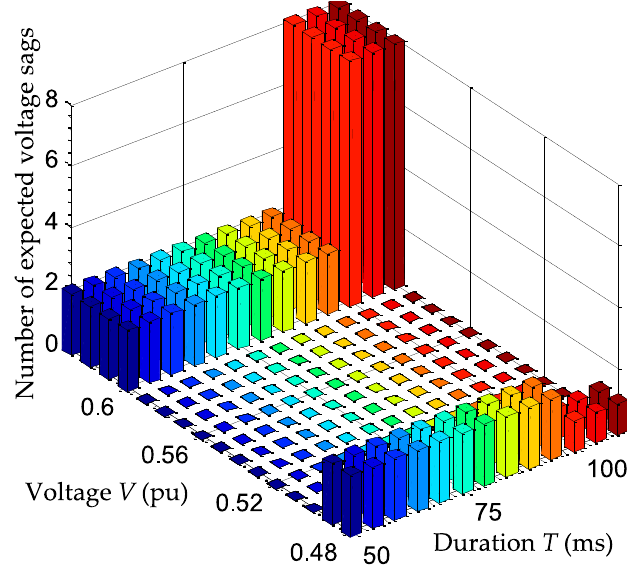
Figure 15. The expected number of voltage sags in a specified time period.